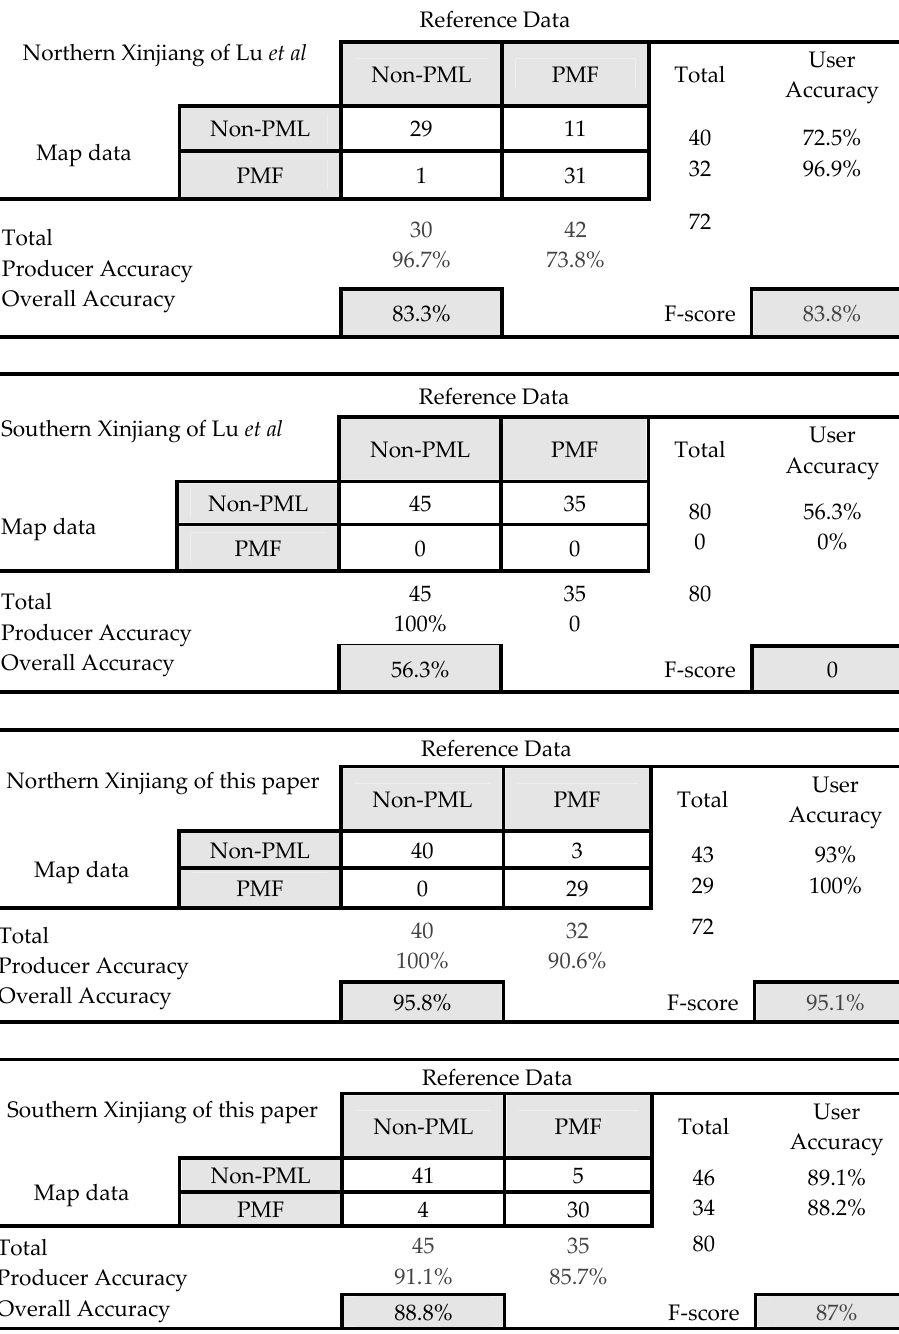
Northern Xinjiang of Lu et